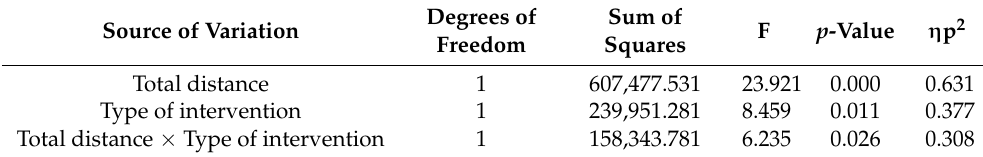
Table 3. Analysis of variance for dependent variable “total distance covered”.